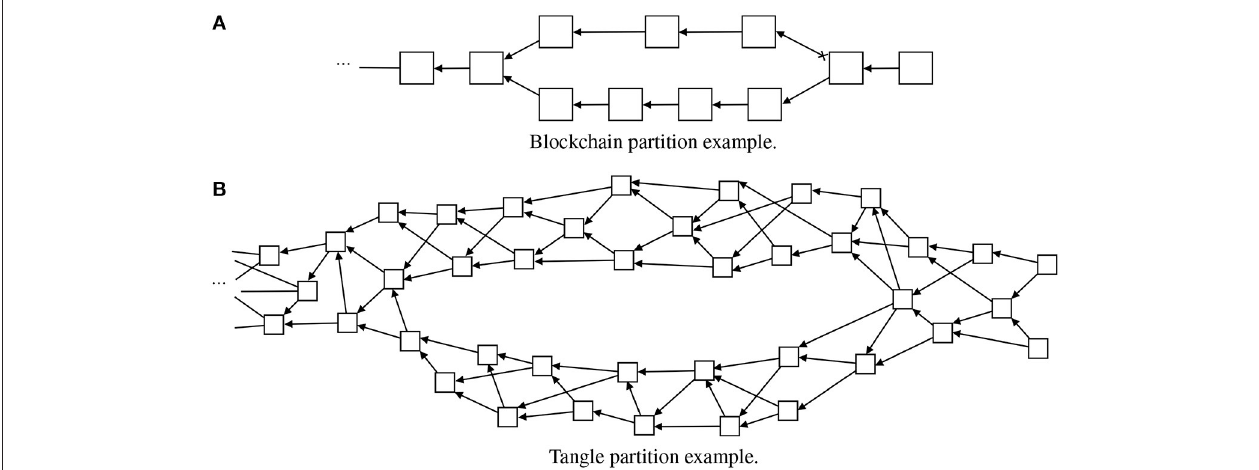
FIGURE 6 | Illustration of how partitions are managed in a typical linear blockchain and in a Tangle. Note that in the blockchain case (A) the upper smaller chain is lost. However, in the Tangle example (B) , both branches are reattached without blocks